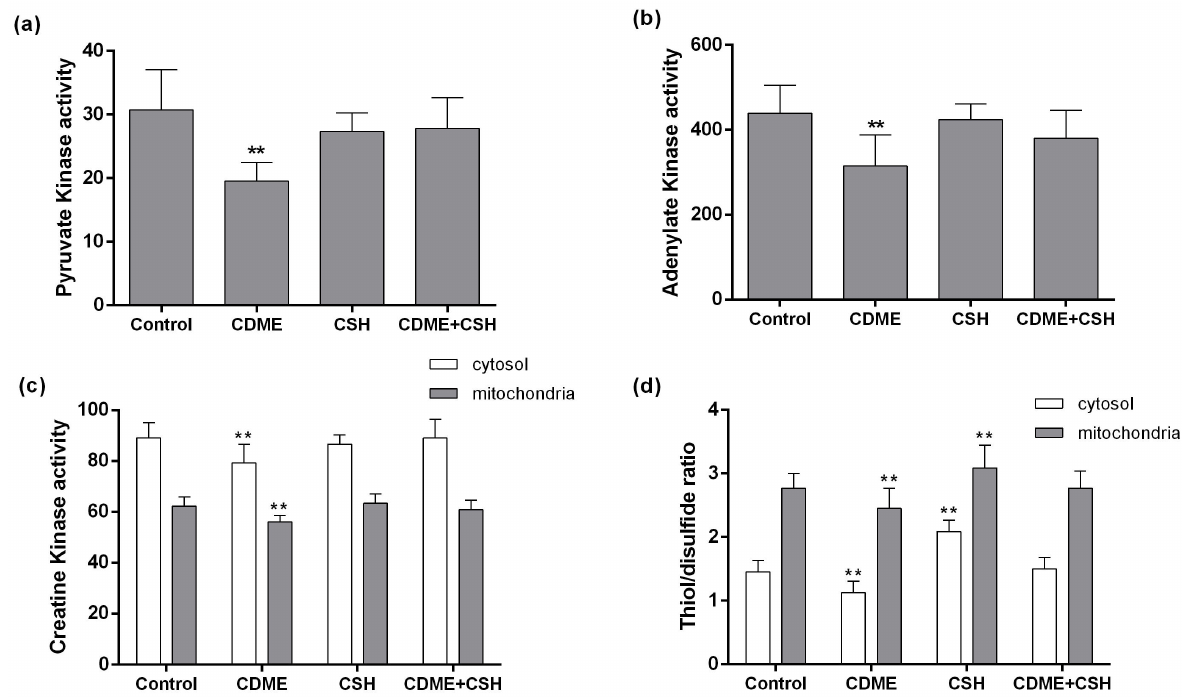
Figure 1 - Effect of CDME and / or CSH administration on ( a ) PK activity of kidney from young rats. PK activity is expressed as nmol of pyruvate formed per min per mg of protein. ( b ) AK activity of kidney from young rats. AK activity is expressed as nmol of ATP formed per min per mg of protein. ( c ) CK activity of kidney from young rats. CK activity is expressed as nmol of creatine formed per min per mg of protein. ( d ) Thiol/disulfide ratio of kidney from young rats. Data are mean ± SD (n=7 animals per group). **p < 0.01 compared to the other groups (Tukey